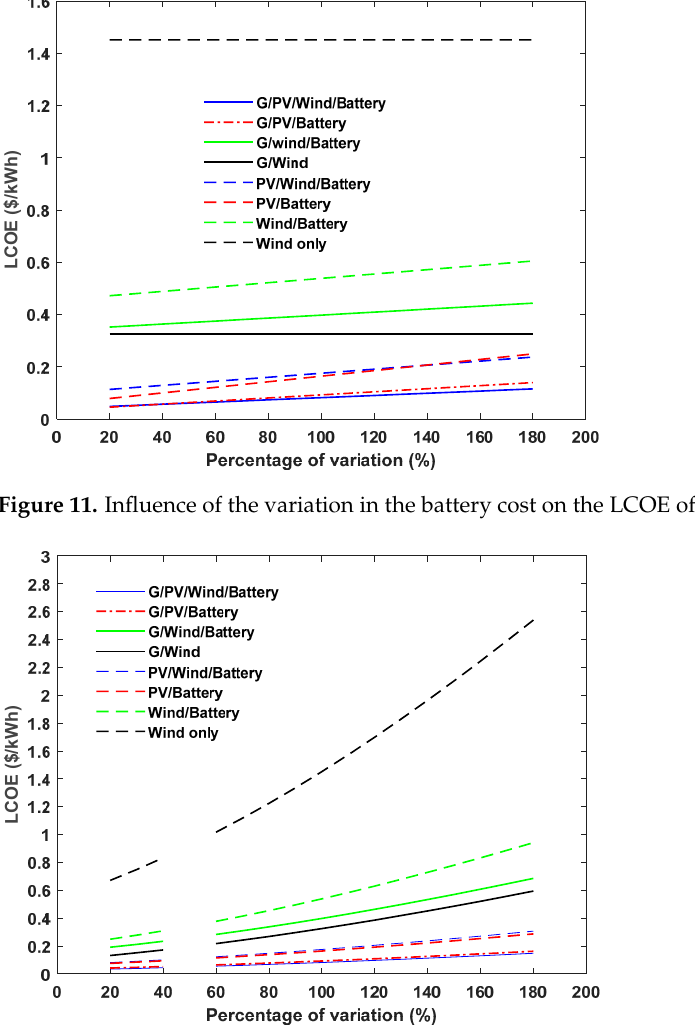
Figure 12. Influence of the variation in the discount rate on the LCOE of the studied systems.